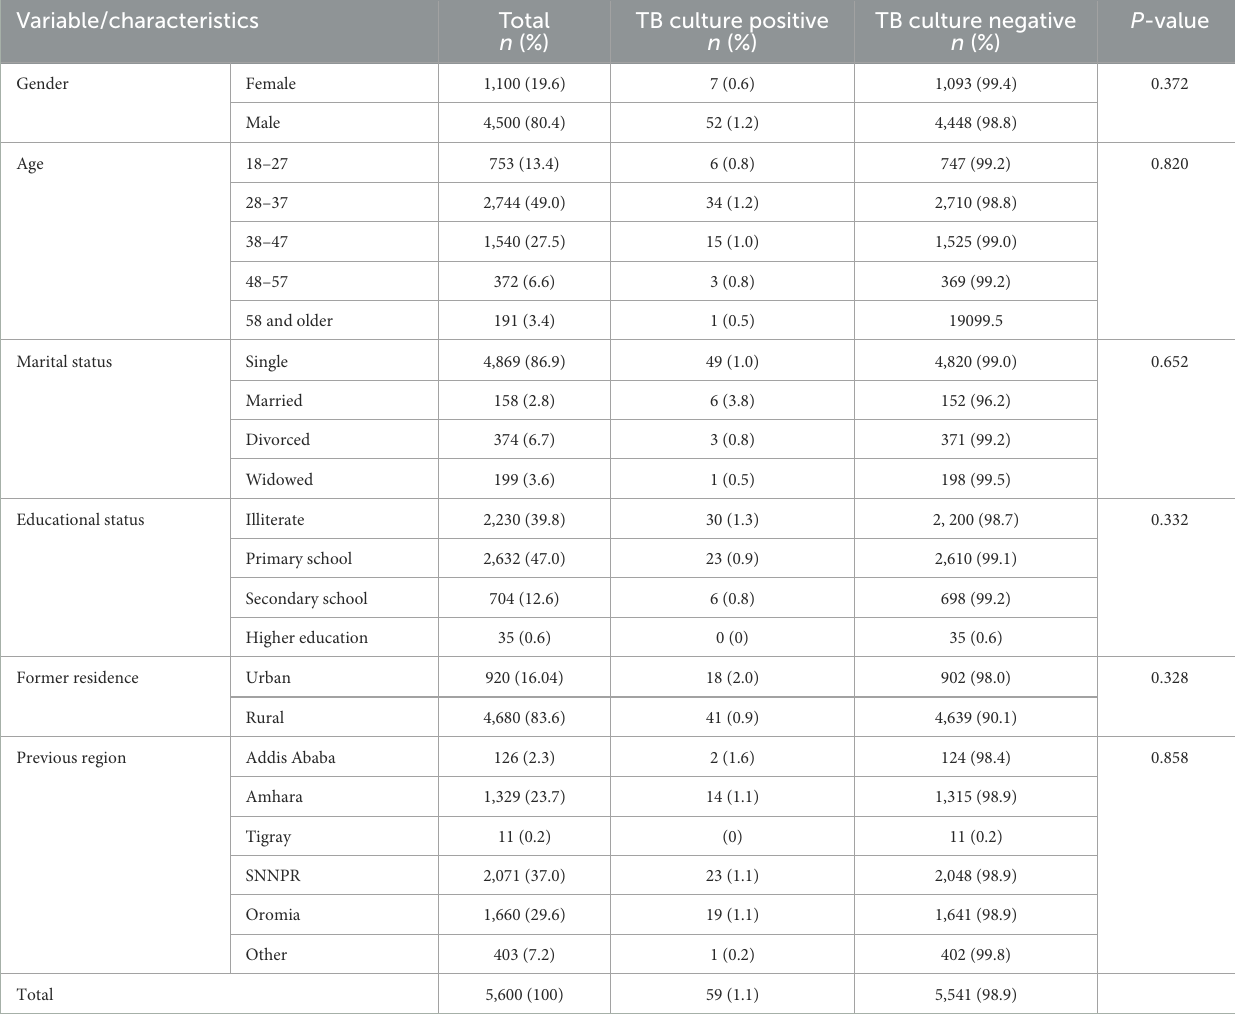
TABLE 1 Socio-demographic characteristics of homeless individuals ( n = 5, 600) with bacteriological confirmed PTB prevalence, Addis Ababa, Ethiopia, 2021. Variable/characteristics